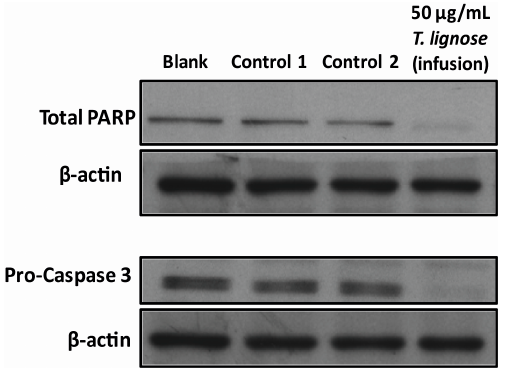
Figure 2. Effect of T. lignosa infusion extract on the NCI-H460 cellular expression levels of total PARP-1 and pro-caspase-3, analyzed by Western blot. Cells were treated for 48 h with complete medium (Blank), Controls (vehicle of the extract, H 2 O), or with 50 µ g/mL of the extract. β -actin was used as loading control. Blots are representative of two independent